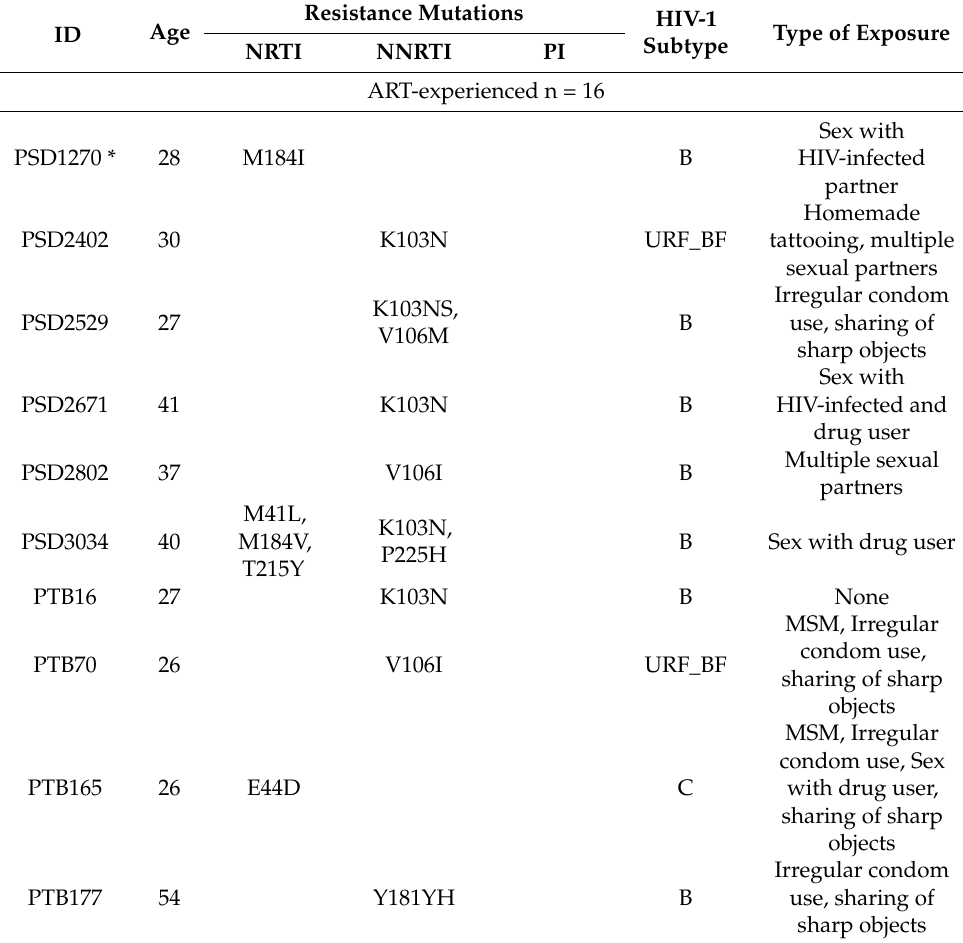
Table 3. Characteristics of the 18 prisoners with DRM, Central Brazil,